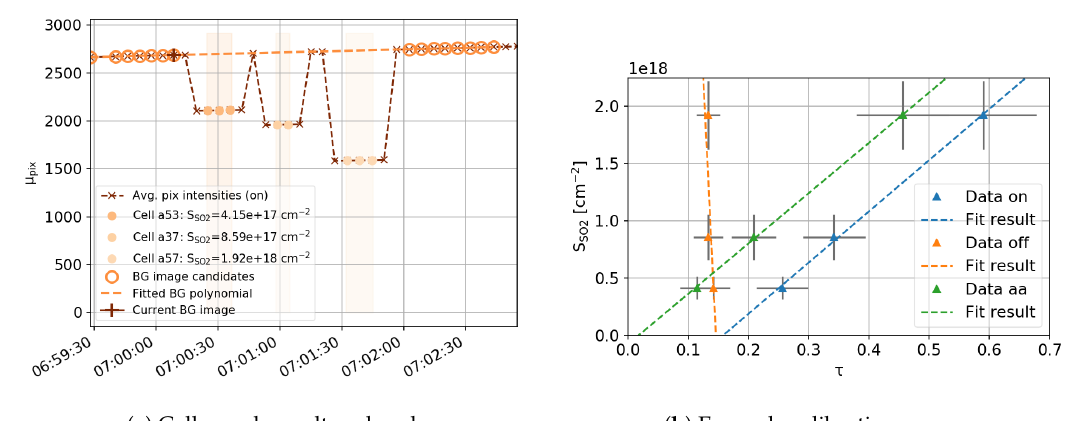
Figure 5. Cell calibration—( a ) shows the output of the automatic cell search routine (included in the CellCalibEngine class); ( b ) shows example calibration curves for τ on , τ off and τ AA images for the image center pixel from the dataset shown in ( a ). The error bars in ( b ) correspond to uncertainties in the cell SO 2 -CDs from the DOAS analysis ( y -axis errors) and the x -errorbars correspond to the min/ max-range of the corresponding τ -values over the entire image (arising from effects due to non-perpendicular illumination, see Section 2.2 for